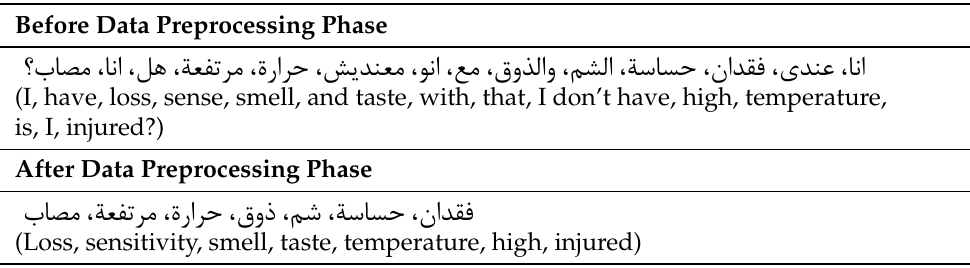
Table 3. Data preprocessing outcome on one Facebook